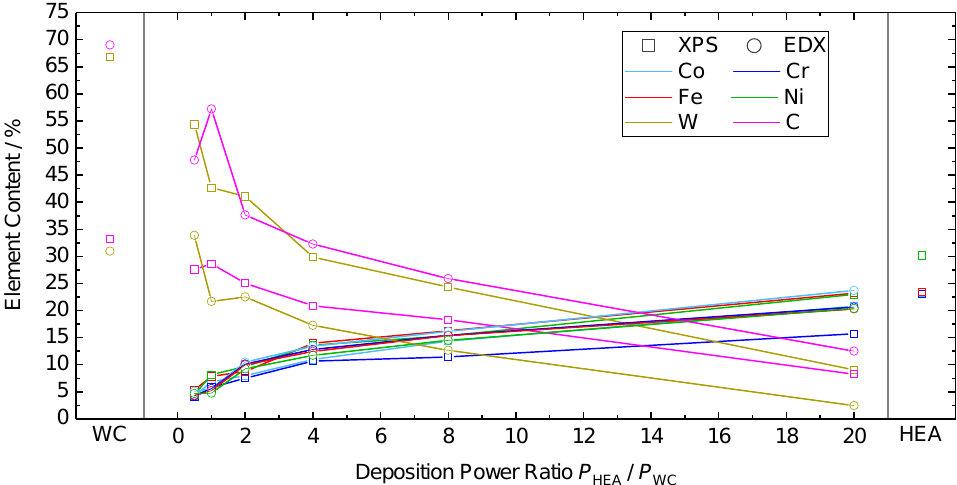
Figure 1. Elemental composition for pure CoCrFeNi (HEA), WC and mixed thin films obtained from XPS ( (cid:3) ) and EDX ( (cid:13) )